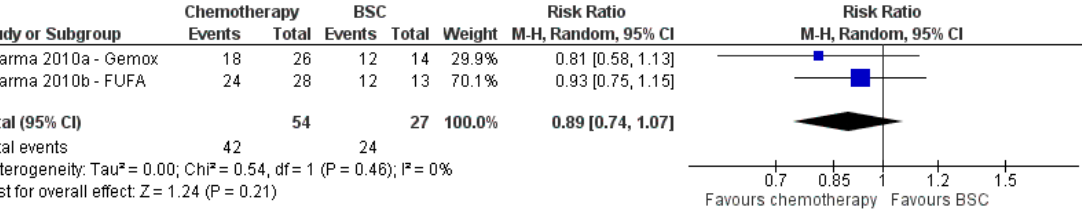
Figure 6. Forest plot for the outcome ‘overall survival’ for the comparison of chemotherapy versus placebo/UPSC in patients with advanced gallbladder cancer.